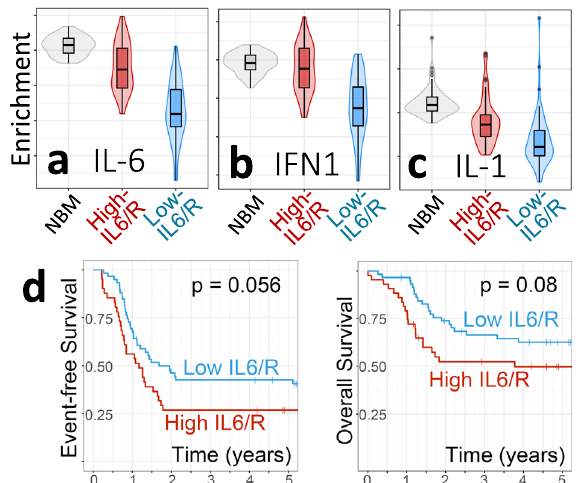
Fig. 2 | Veri fi cation of fi ndings in an independent cohort using the same gene sets and scoring as in the discovery cohort (Fig. 1, Supplementary Fig. 2B). a IL-6 signaling, b Type 1 IFN signaling, c IL-1 signaling. Shown are gene set mean expressionlevelsinhigh-vs.low-IL6/Rsamples. d Comparisonof5-yearEvent-Free and Overall Survival for high- vs. low-IL6/R patients. Log-rank p -values are shown. Boxplotsshowthemedianandtheupperandlowercentral-quartiles.Theexpected range of the datais indicated bywhiskers. In all panels n =43for high-IL6/Rgroup, n =59 for the low-IL6/R group., and n =62 for